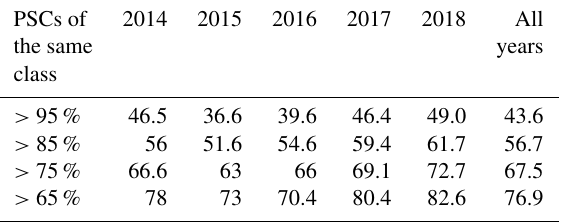
Table 2. The percentage of pixels on the altitude tracks with at least X percent of PSCs of the same class. PSCs